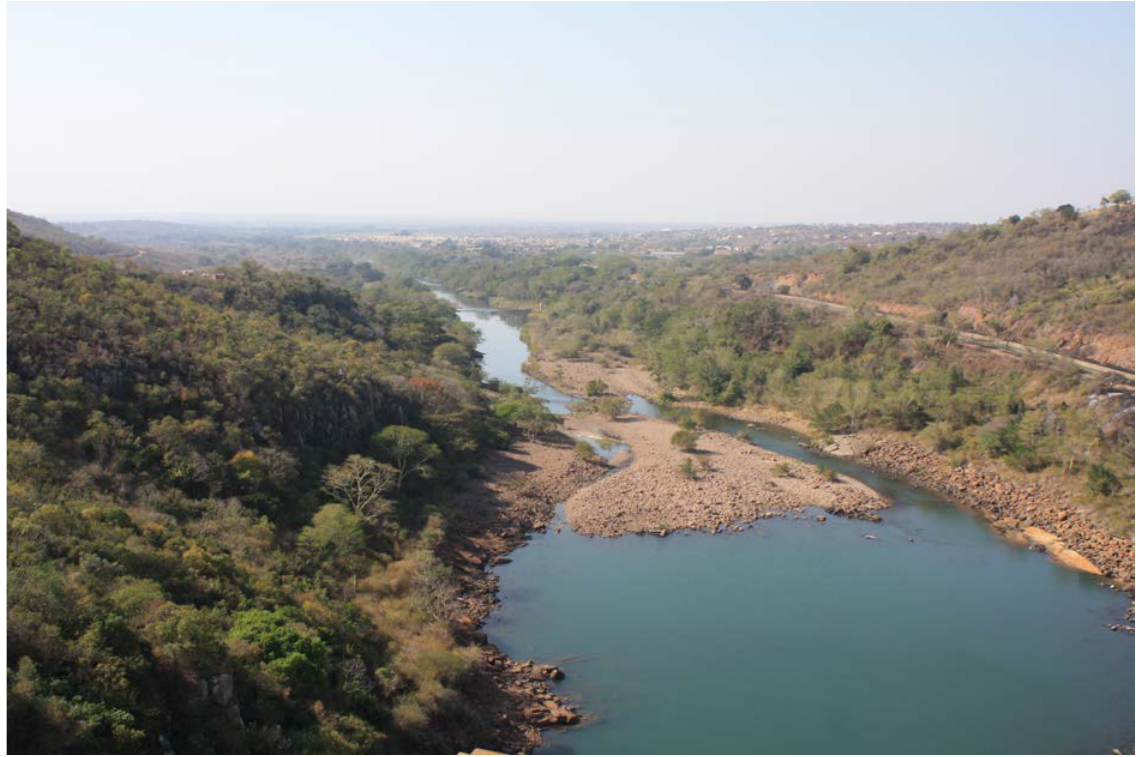
Illustration 13 : The Pongola River downstream of the Pongolapoort Dam .